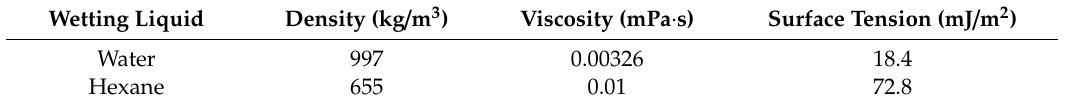
Figure 5. Laboratory set-up used for contact angle measurements by capillary rise method: 1—Electronic Balance, 2—Container with liquid, 3—Wetted sections of tapped solids, 4—Particle bed, 5—Column with 5 mm diameter, 6—Micrometric screw. Table 2. Characteristics of liquids used for capillary rise experiments (20 °C).